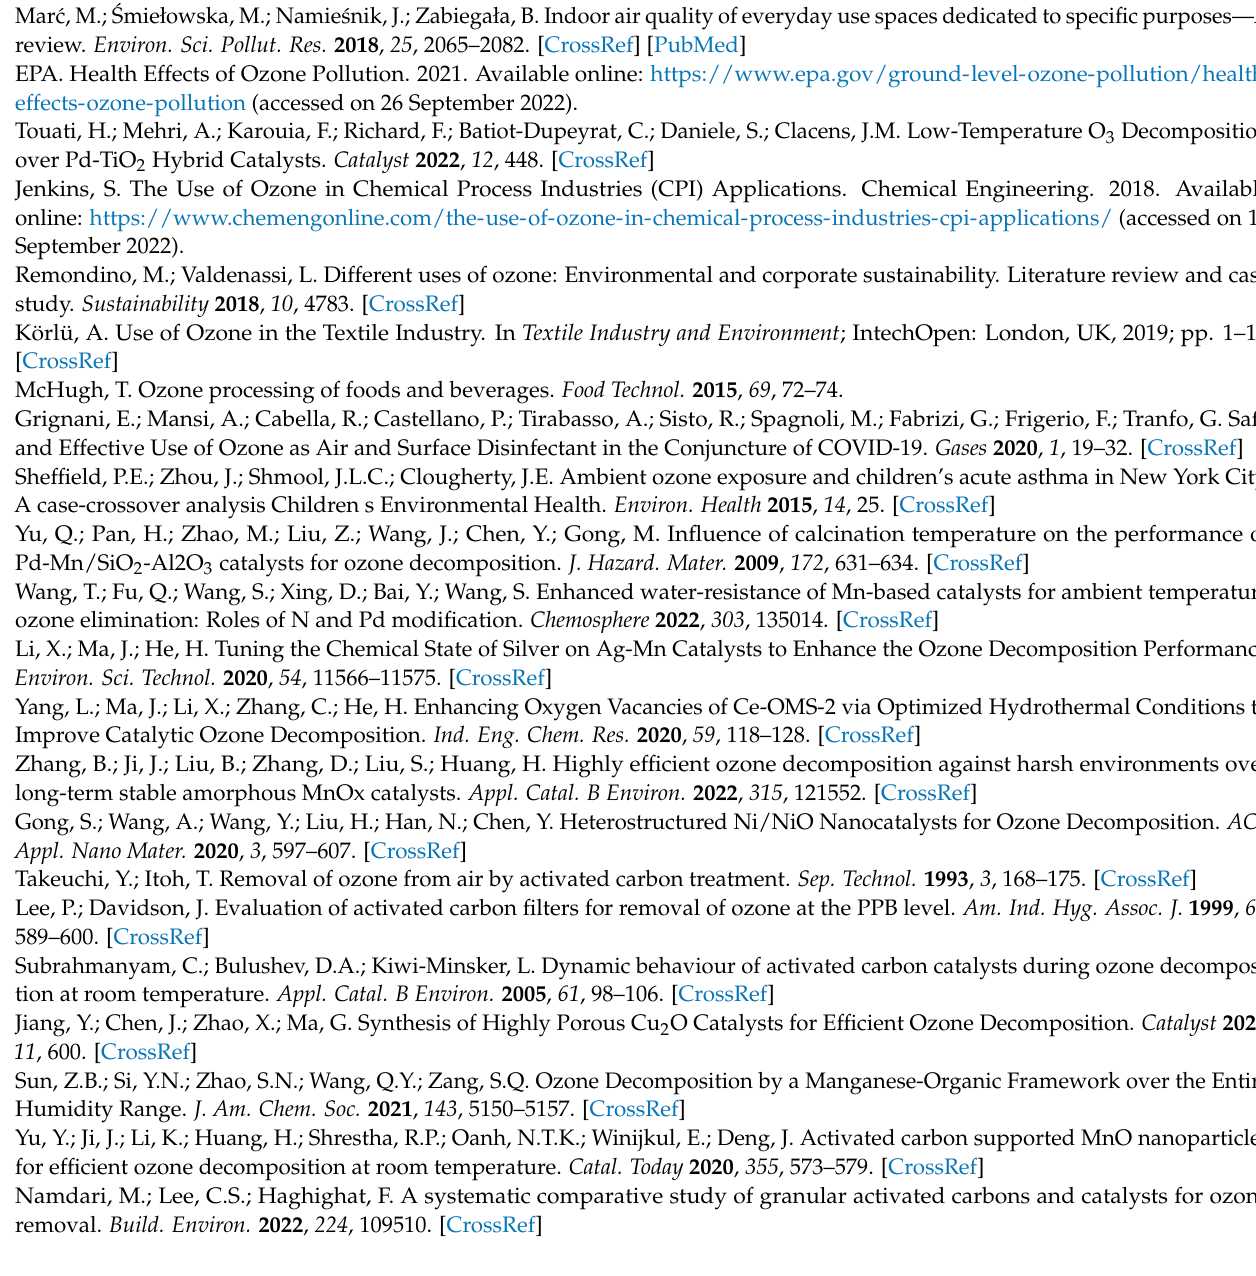
Table S1: Specific surface area comparison of previous studies with the results reported in this